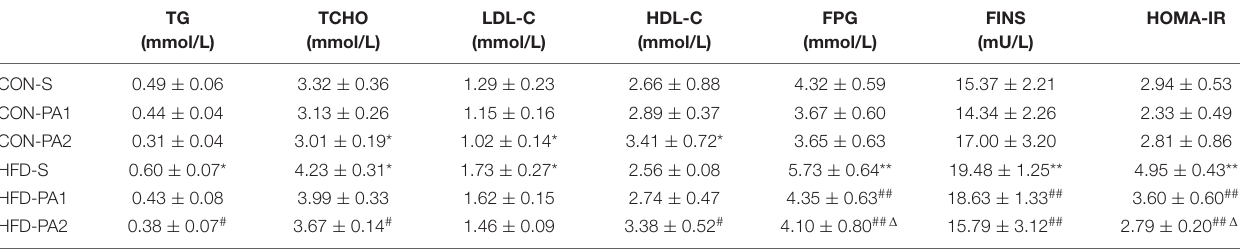
TABLE 3 | Serum biochemical parameter tests at termination.